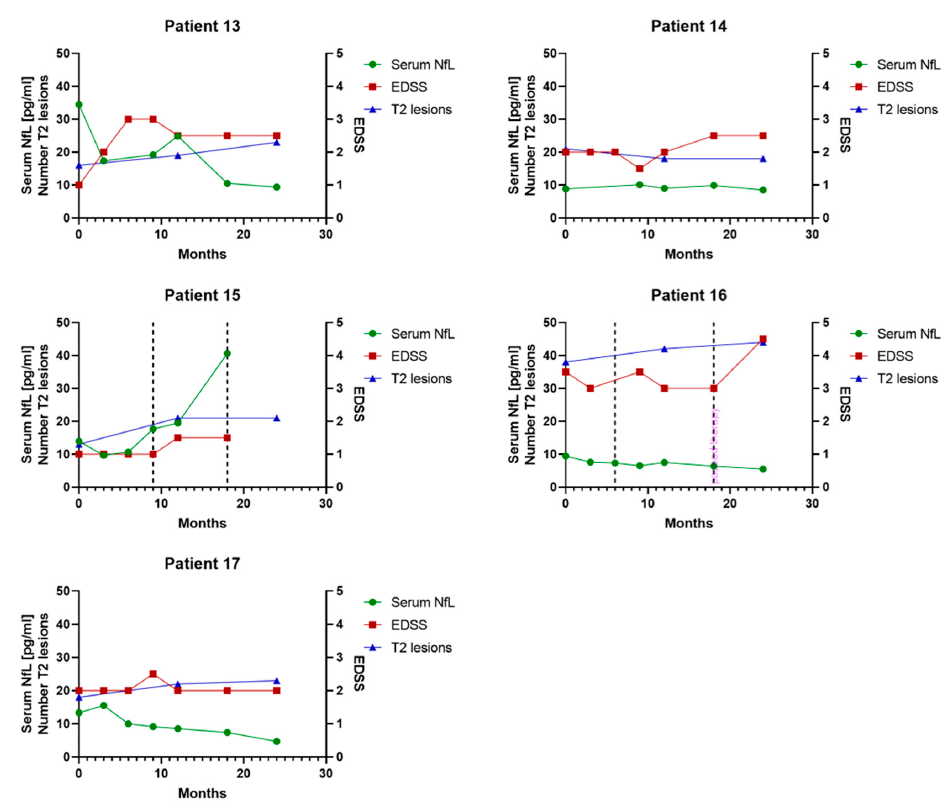
Figure 6. Illustration of individual serum NfL courses over 24 months in patients with initiation of disease-modifying treatment with glatiramer acetate after baseline. Green circles, red squares and blue triangles show serum NfL values (left y-axis), EDSS (right y-axis) and the number of T2 lesions (left y-axis), respectively. Vertical dashed lines show events of clinical activity in the form of a relapse at this time point.